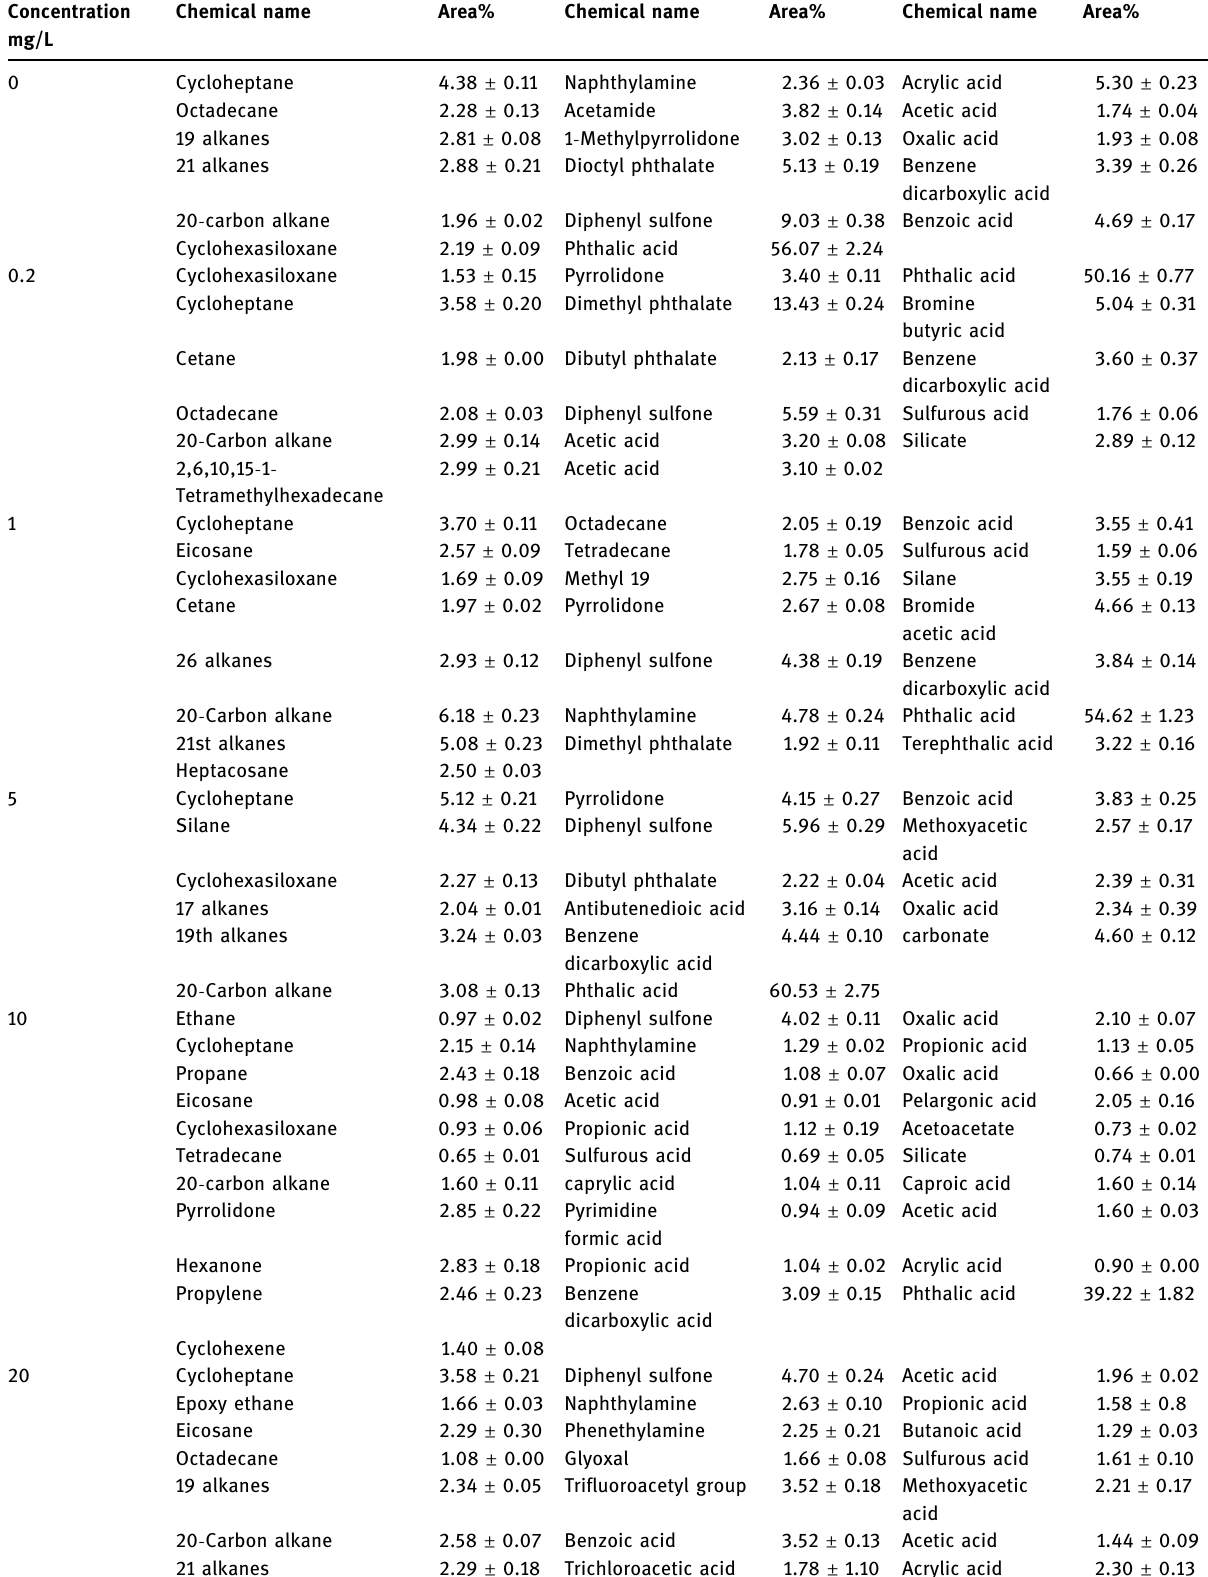
Table 3: Major root exudates of Cyperus alternifolius exposed to a concentration gradient of phosphorus Concentration